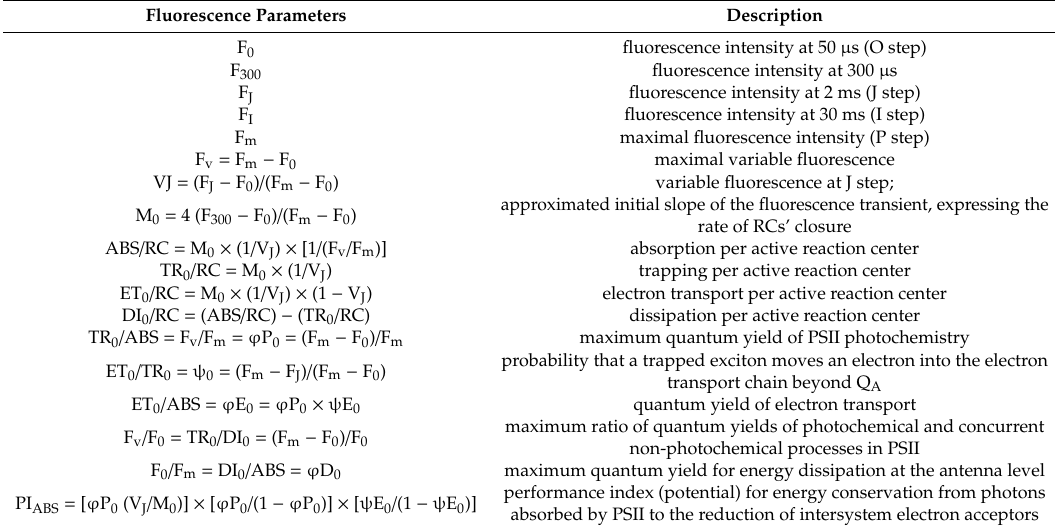
Table 1. Selected JIP-test parameters calculated on the basis of fast fluorescence